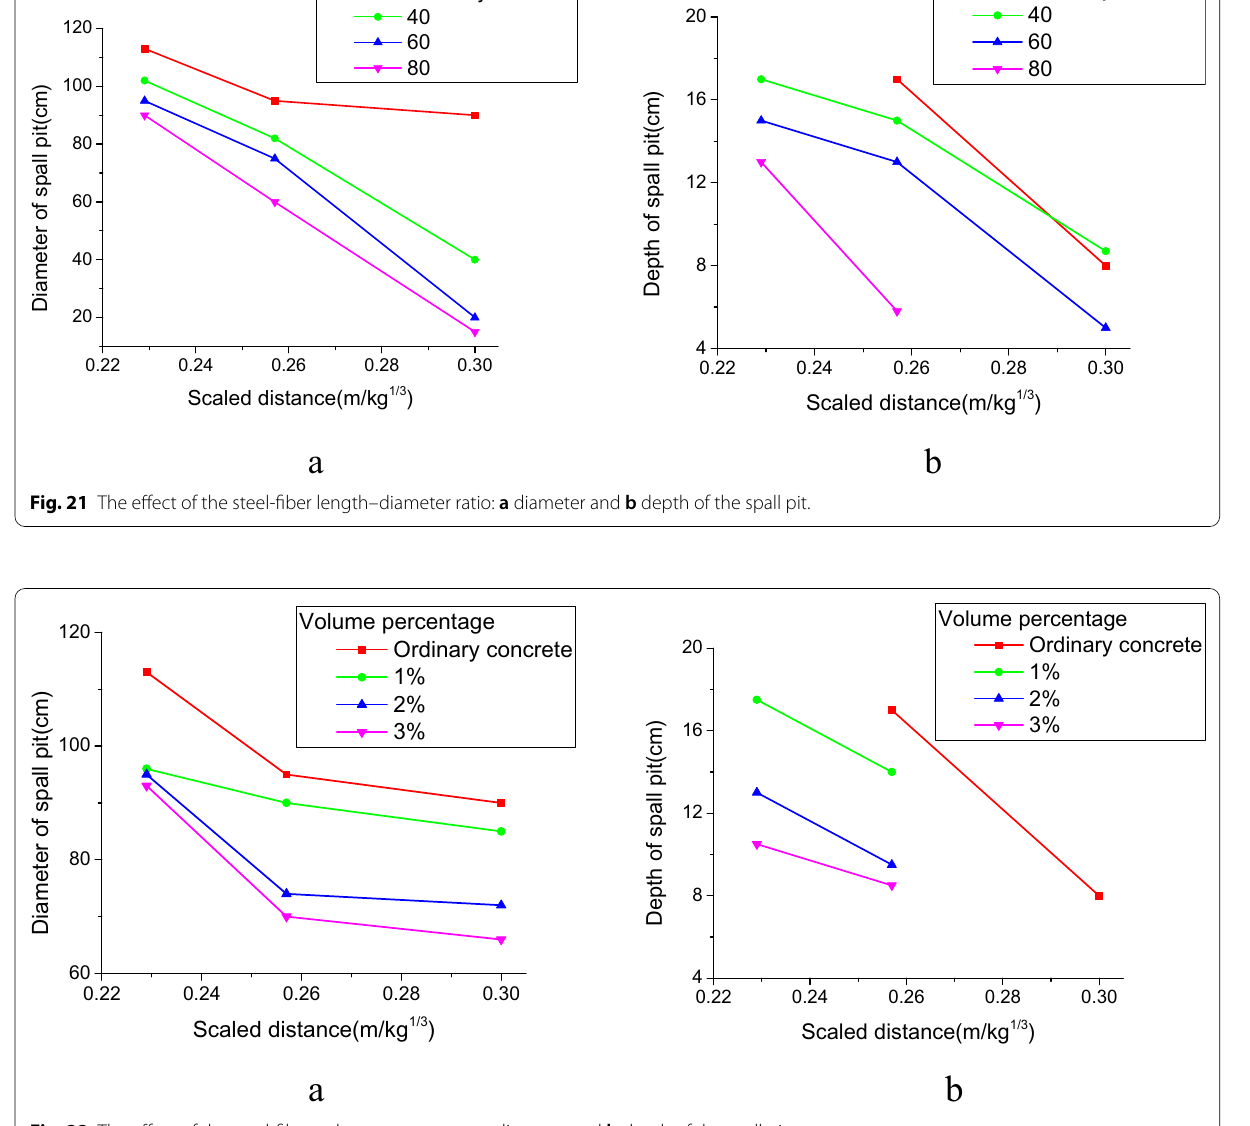
Fig. 22 The effect of the steel-fiber volume percentage: a diameter and b depth of the spall